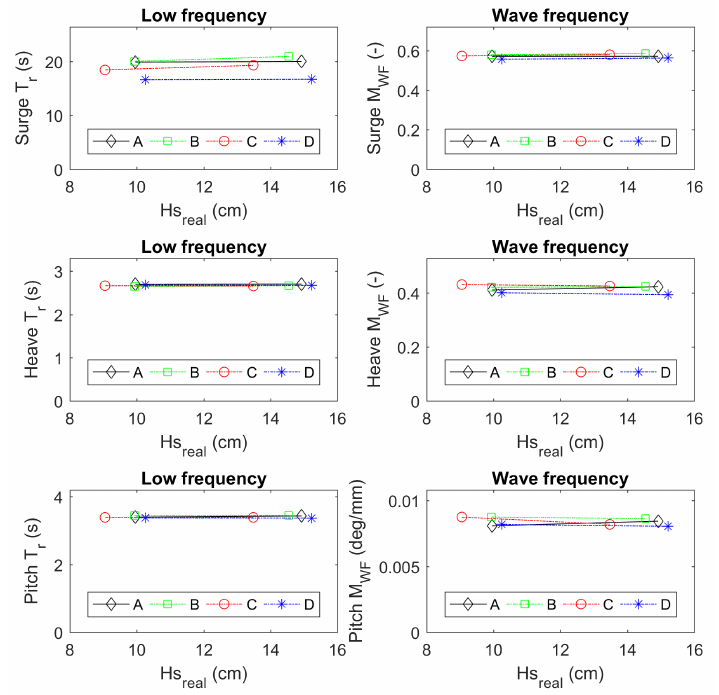
Figure 19. Metrics T r (left column) and M WF (right column) applied to surge (top row), heave (middle row), and pitch (bottom row) motions for realised significant wave height ( H s JONSWAP T p = 1.81 s, H s = 10 cm, and 15 cm per facility.